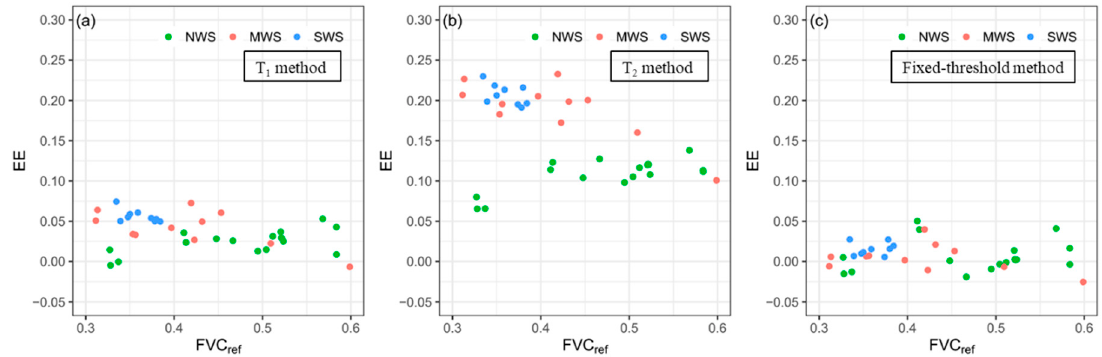
Figure 9. Estimation errors (EEs) of all test group images with FVC ref ranging from 0.3 to 0.6, obtained by ( a ) T 1 method, ( b ) T 2 method, and ( c ) fixed-threshold method. NWS, MWS, and SWS represent no water stress, intermediate water stress, and severe water stress, respectively.